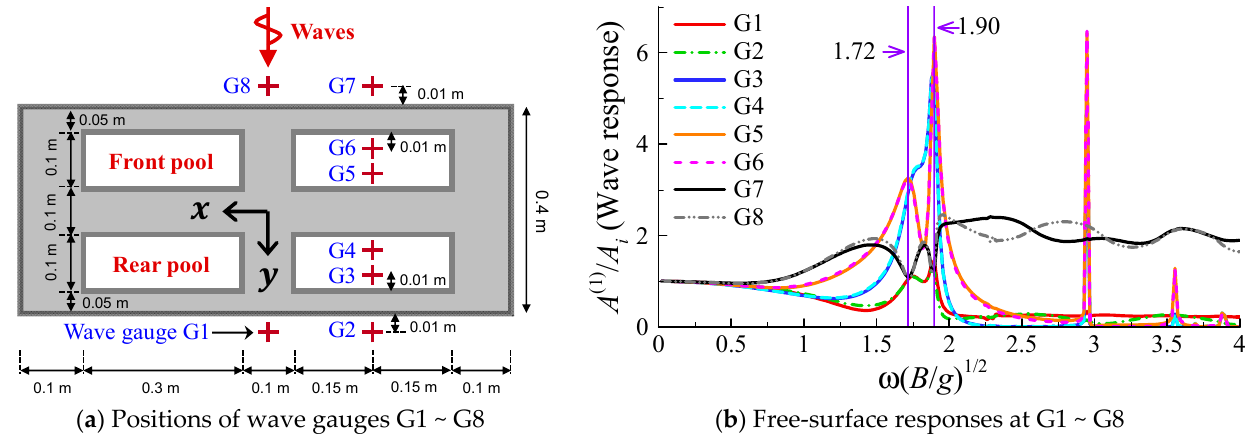
Figure 9. Calculated first-order wave responses inside/outside the moonpools of a fixed barge in beam waves. Furthermore, to explore the reason why the water resonance in moonpools could reduce horizontal mean drift force, the time histories of the wave responses at G1 ~ G8 were plotted based on the first-order frequency-domain solutions, as shown in Figure 10. Water motions at G1, G3, G5 and G7 were found to be almost in phase with their counterparts at G2, G4, G6 and G8, respectively. The oscillating amplitudes in the front and rear moonpools (defined in Figure 9a) were similarly much larger than those outside the moonpools. The water oscillations in the front and rear moonpools were close to in-phase motions at ω ( B / g ) 0.5 = 1.72, and were close to anti-phase motions at ω ( B / g ) 0.5 = 1.90. As for wave motion outside the moonpools, the most important finding from Figure 10 is that the wave run-up amplitudes at the windward and leeward sides of the barge were very close at the resonant frequencies, particularly at ω ( B / g ) 0.5 = 1.72 (resonant frequency of the first mode). This result well explains the highly reduced mean sway drift forces at resonance shown in Figure 8a, where the mean sway drift force at ω ( B / g ) 0.5 = 1.72 was observed to be almost zero. From a physical point of view, the phenomenon of similar run-ups at the wave incidence and transmission sides of the barge can be attributed to the significant radiation effect of moonpool resonance dominating the wave diffraction effect.